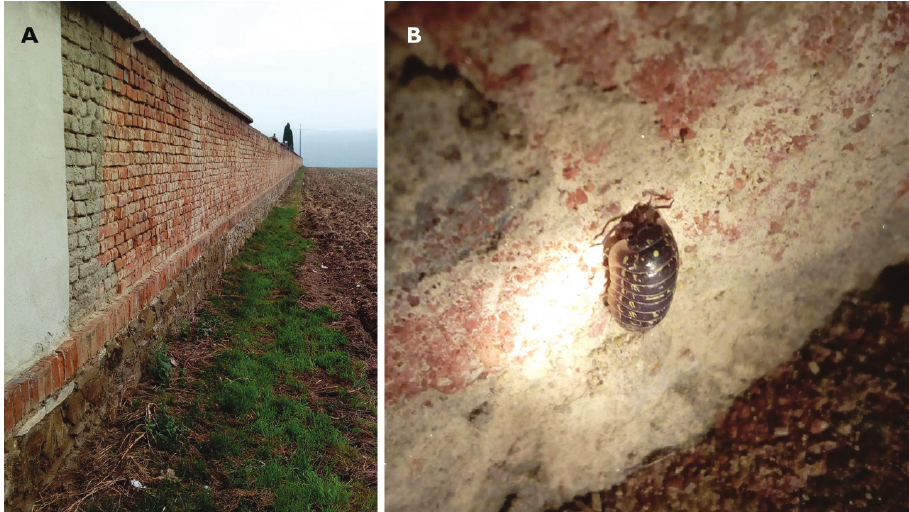
Figure 2. A the studied brick cemetery wall B Armadillidium versicolor climbing on the wall (photographs